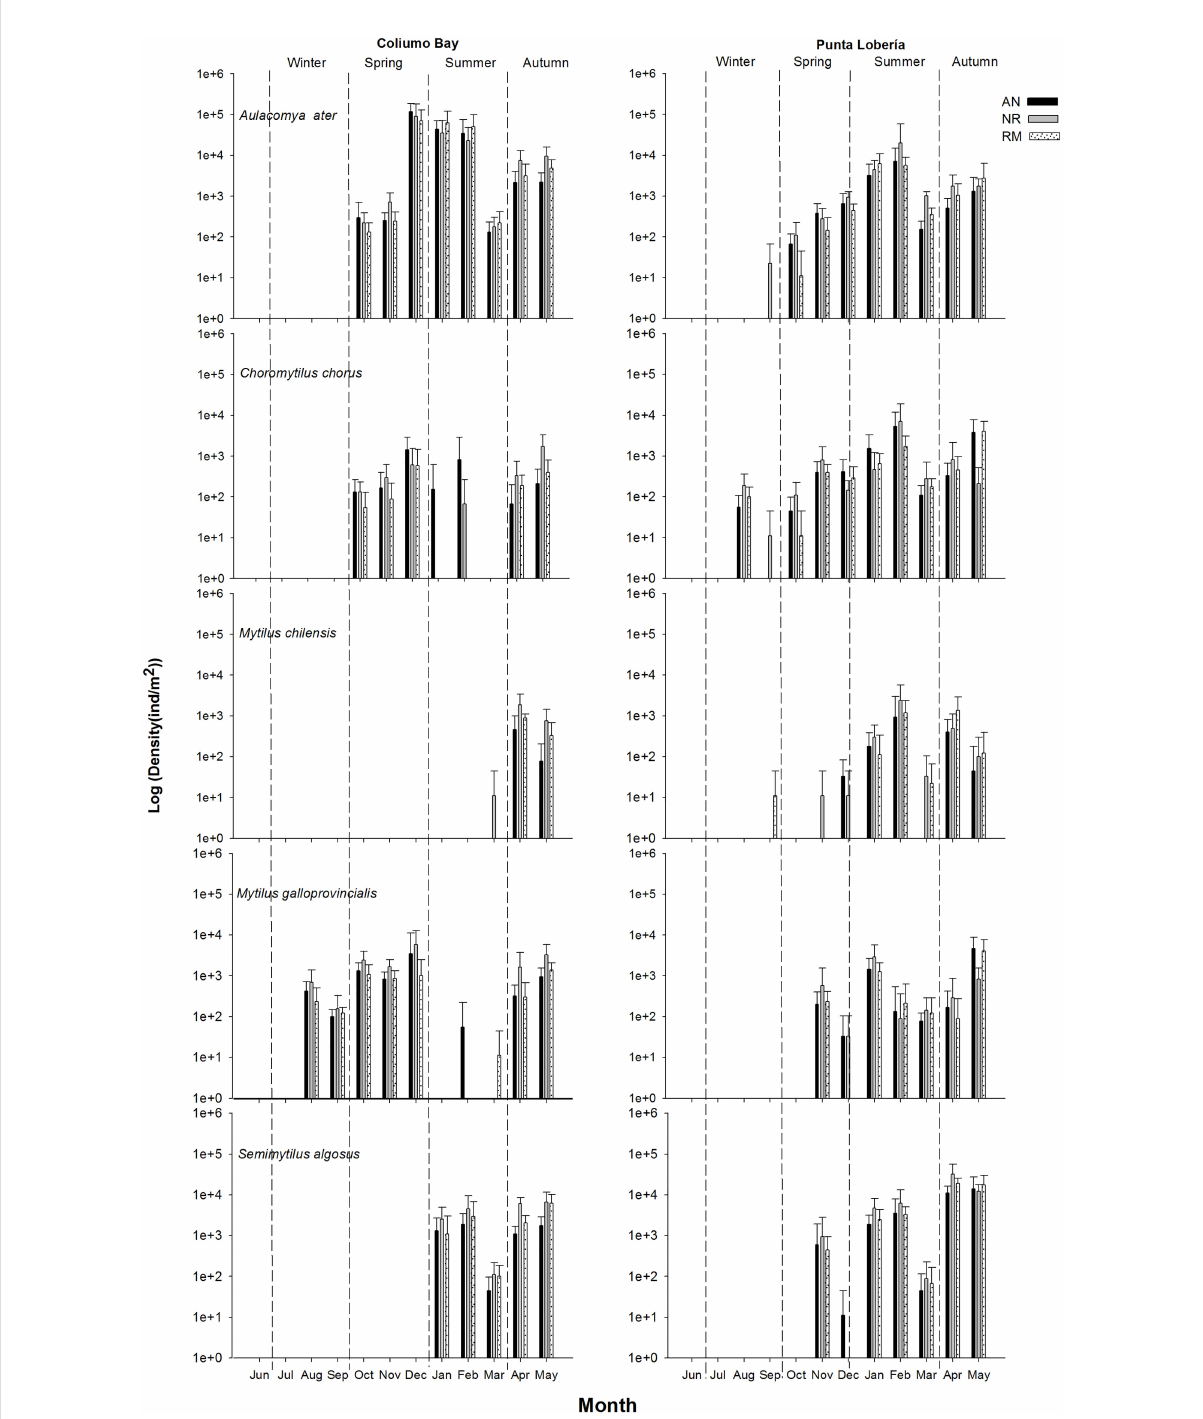
FIGURE 5 Spat density at logarithmic scale for each species at both coastal sites (AN, anchovy net; NR, nylon rope; RM, raschel mesh). Error bars indicate + 1 standard